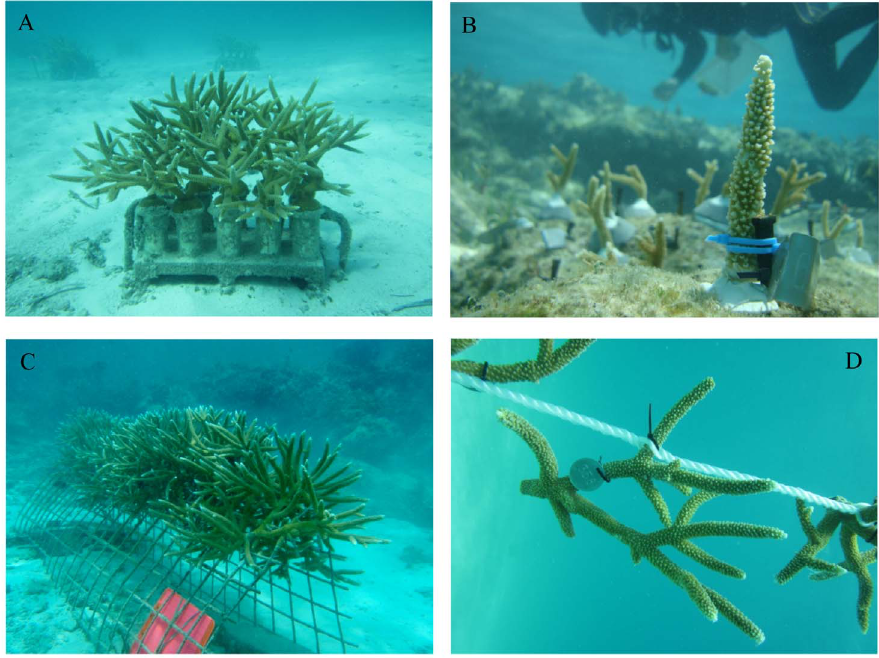
Figure 1. Staghorn fragments propagated within insitu nurseries. A) Cinder-block platform used to propagate corals in Florida, B) coral outplant attached to a reef using a masonry nail, epoxy, and plastic ties, C) A-frame used to propagate corals in the Dominican Republic, D) rope nursery.